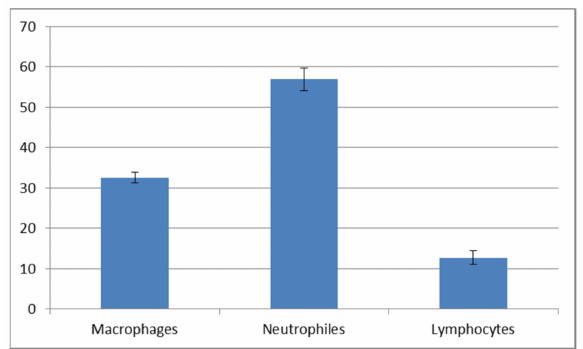
Figure 9. Percentage share of immune cells in the autumn-winter mucus.